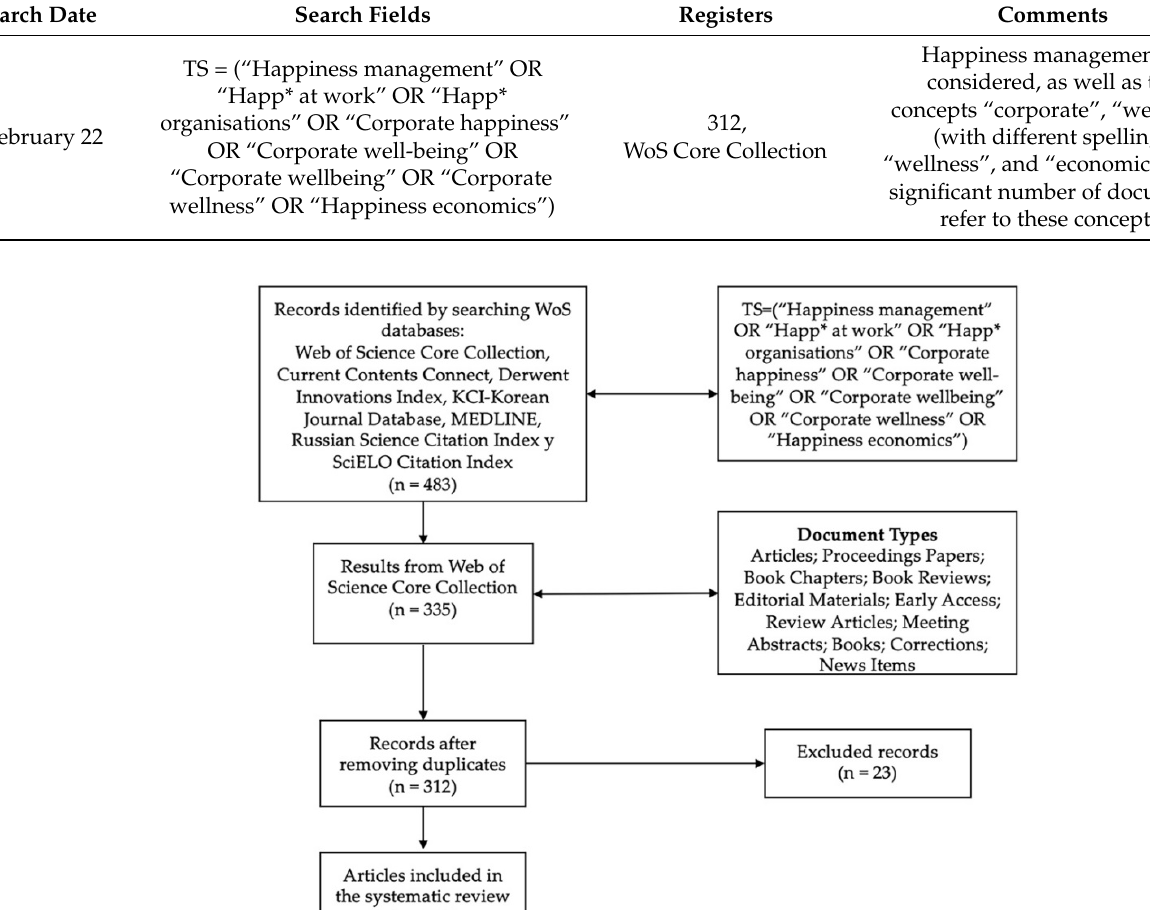
Table 1. Results of the WoS search for bibliometric analysis.